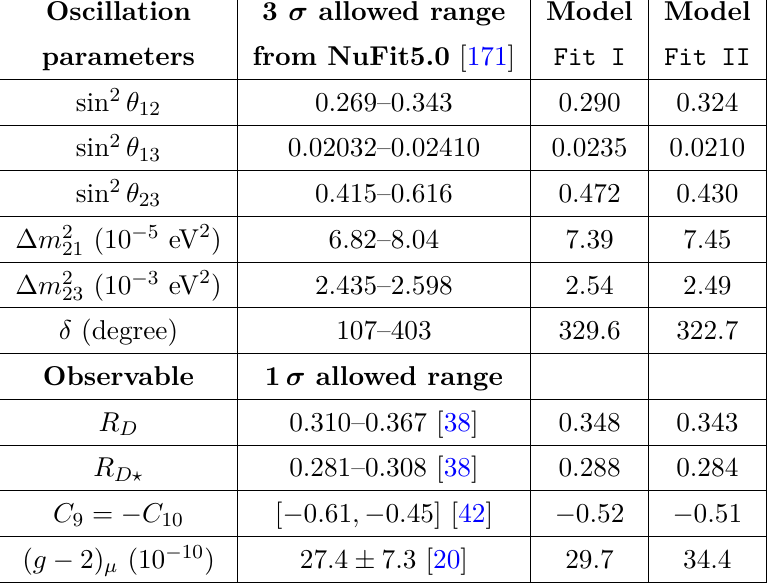
Table 4 . Fits to the neutrino oscillation parameters in the model with normal hierarchy, along with the B -anomalies, and muon g − 2 for two benchmark fits given in eq. (7.3) and eq. (7.4). For comparison, the 3 σ allowed range for the oscillation parameters and the 1 σ range for the other observables are also given. Note that correlation between R D and R D ∗ is not taken into account here (see figure 10 to see such